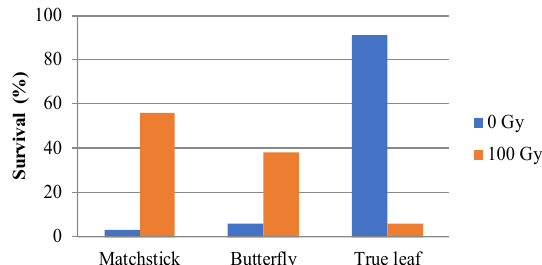
Figure 5. Effect of 100 Gy gamma irradiation on the grade of development of M1 coffee ( Coffea arabica L. var. typica) plants grown under nursery conditions “Genova Farm” San Ramon District, Department of Junín, Peru.